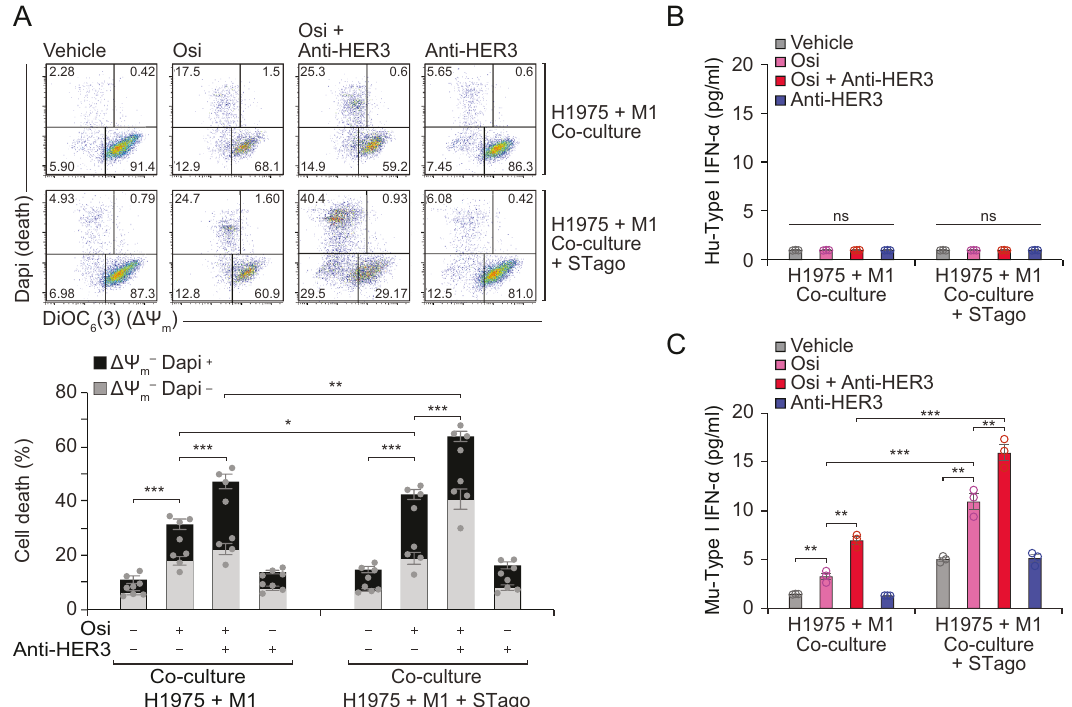
Fig. 7 Addition of a STING agonist leads to increased type-I IFN production in macrophages and enhances macrophage-mediated tumor toxicity. A H1975 cells pre-treated with osimertinib (Osi, 200 nM, 24 h) and anti-HER3 (MP-RM-1, 10 μ g/ml, 1 h) were co-cultured with M1-like bone marrow derived macrophages (BMDM) or BMDMs pre-treated with STING agonist (STago) 2 ’ 3 ’ -cGAMP as indicated in materials and methods. Apoptosis of H1975 cells was assessed by fl ow cytometry excluding BMDMs; cells labelled with DiOC 6 (3) for mitochondrial transmembrane potential ( ΔΨ m ) and Dapi for cell viability, as described in materials and methods. Dot plots are representative of 3 independent replicates. A quanti fi cation summary is shown in the lower graph. Results shown as mean ± SEM from three replicates; *** P < 0.001, ** P < 0.01 as indicated, using one-way ANOVA with Tukey ’ s test. B Quanti fi cation of H1975-derived human type-I IFN. H1975 cells pre- treated with osimertinib (Osi, 200 nM, 24 h) and anti-HER3 (MP-RM-1, 10 μ g/ml, 1 h) were co-cultured for 24 h with M1-like bone marrow derived macrophages (BMDM) or BMDMs pre-treated with STING agonist (STago) 2 ’ 3 ’ -cGAMP, then supernatants were assessed for ELISA as described in materials and methods. Data are shown as mean ± SEM. Non-signi fi cant (ns) differences quanti fi ed using unpaired t -test. C Quanti fi cation of macrophage-derived murine type-I IFN. H1975 cells were pre-treated with osimertinib and anti-HER3, then co-cultured with BMDMs as detailed for Panel B. Supernatants were assessed for ELISA as described in materials and methods. Data shown as mean ± SEM. *** P < 0.001, ** P < 0.01 as indicated, using unpaired t